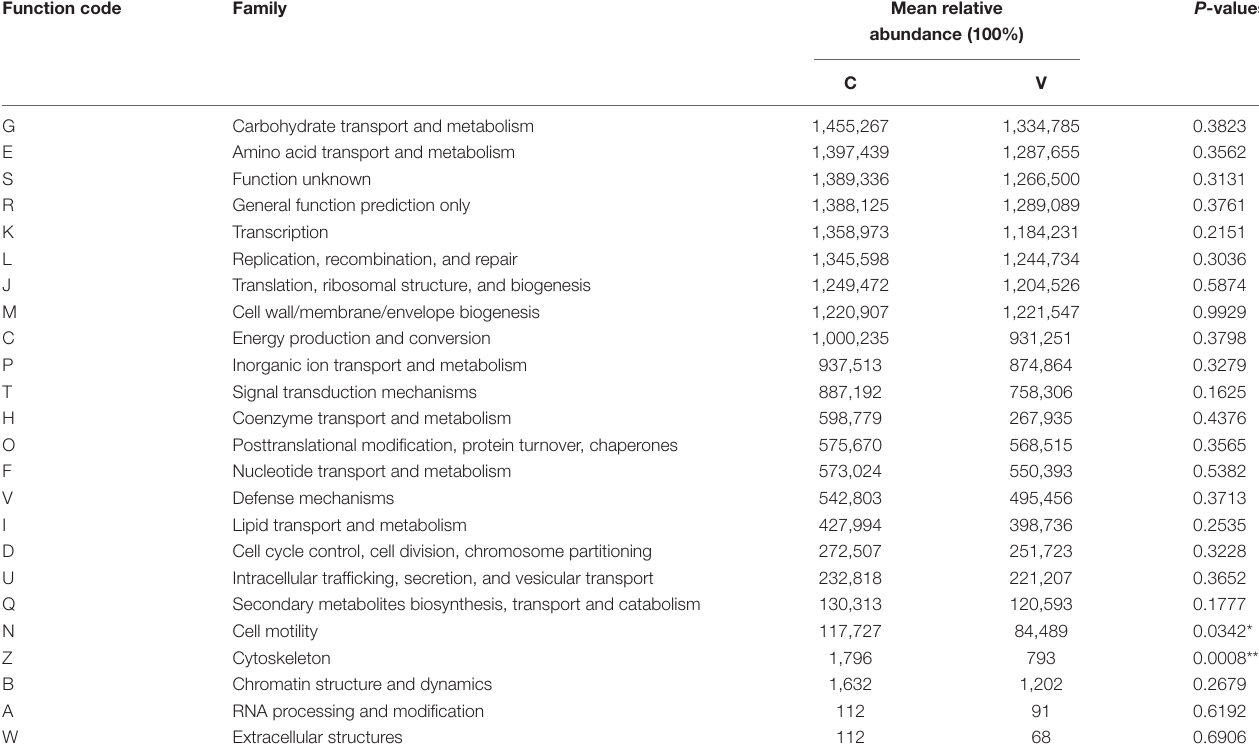
TABLE 2 | Comparisons of clusters of orthologous groups (COG) functional abundance between PCV3- (V) and sham-inoculated (C) piglets at 21 dpi. Function code